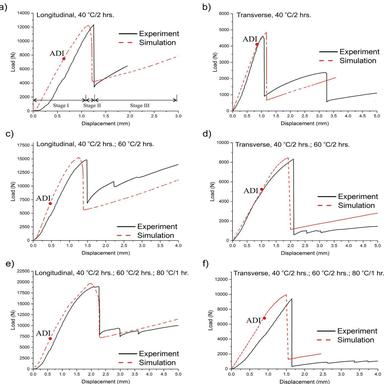
Numerical and experimental load-displacement curves of the ABCSS under three-point bending test with different loading directions and cuing histories as labelled.